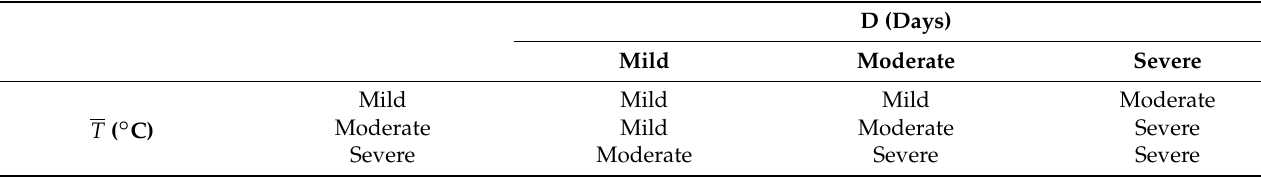
Table 3. Severity criteria of spring